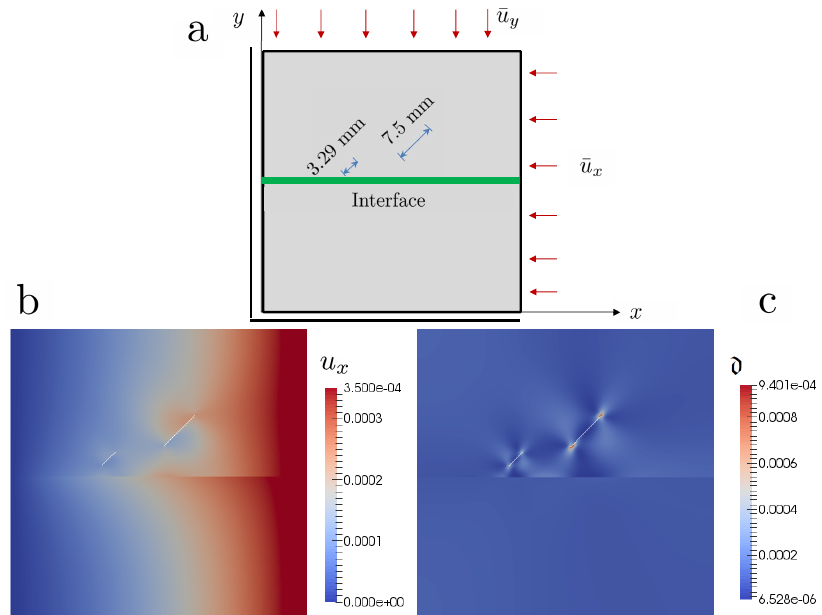
Figure 13. ( a ) Specimen with 2 inclined flaws and a horizontal joint. Case ¯ u y = − 0.2 ¯ u x : ( b ) horizontal displacement field; ( c ) damage